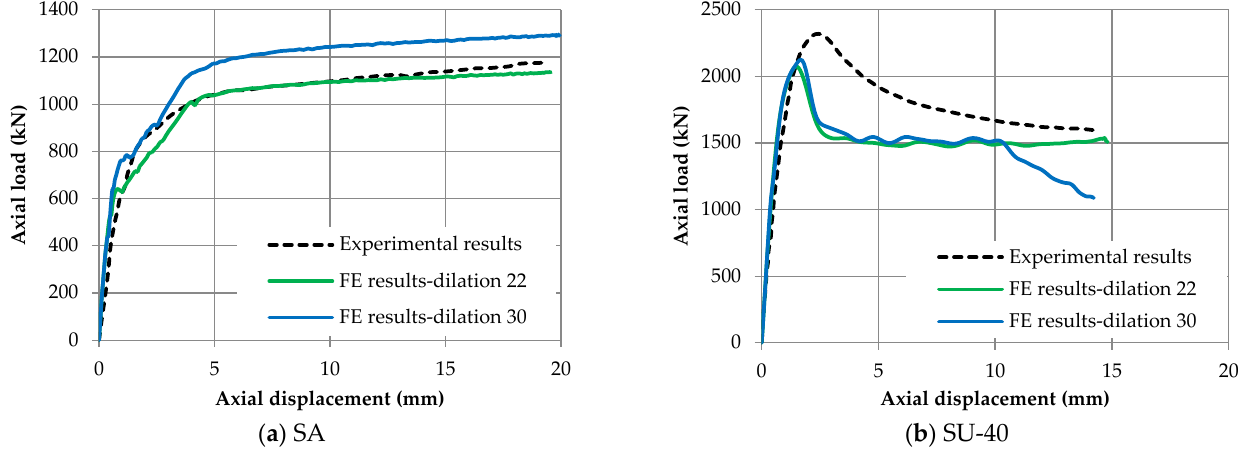
Figure 12. Load-deflection curves of the simulated specimens using different dilation